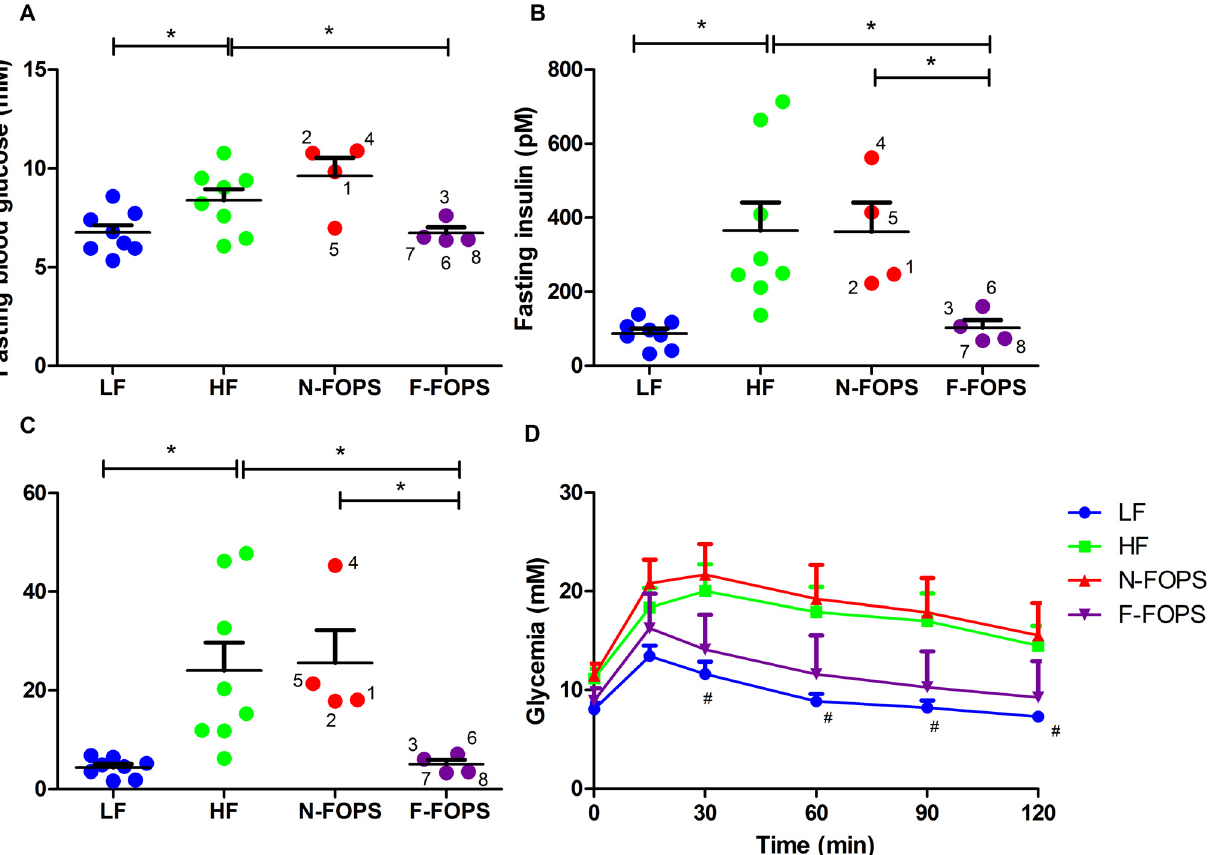
Fig 4. Intraperitoneal glucose tolerance test in mice after 7 weeks of feeding. Fasting glycemia (A), fasting insulinemia (B), index of insulin resistance (C), and glucose tolerance curve (D); data are presented as mean ± SEM; n = 8 mice/group for HF and LF; n = 4 mice/group for N-FOPS and F-FOPS; mouse numbers are shown for FOPS mice to track individual mice across figures; * indicates a significant difference (p < 0.05) between the indicated treatments using Bonferroni ’ s multiple comparison test with the following comparisons: LF vs. HF; HF vs. N-FOPS; HF vs. F-FOPS; F-FOPS vs. Y-FOPS; #, p < 0.05 vs.